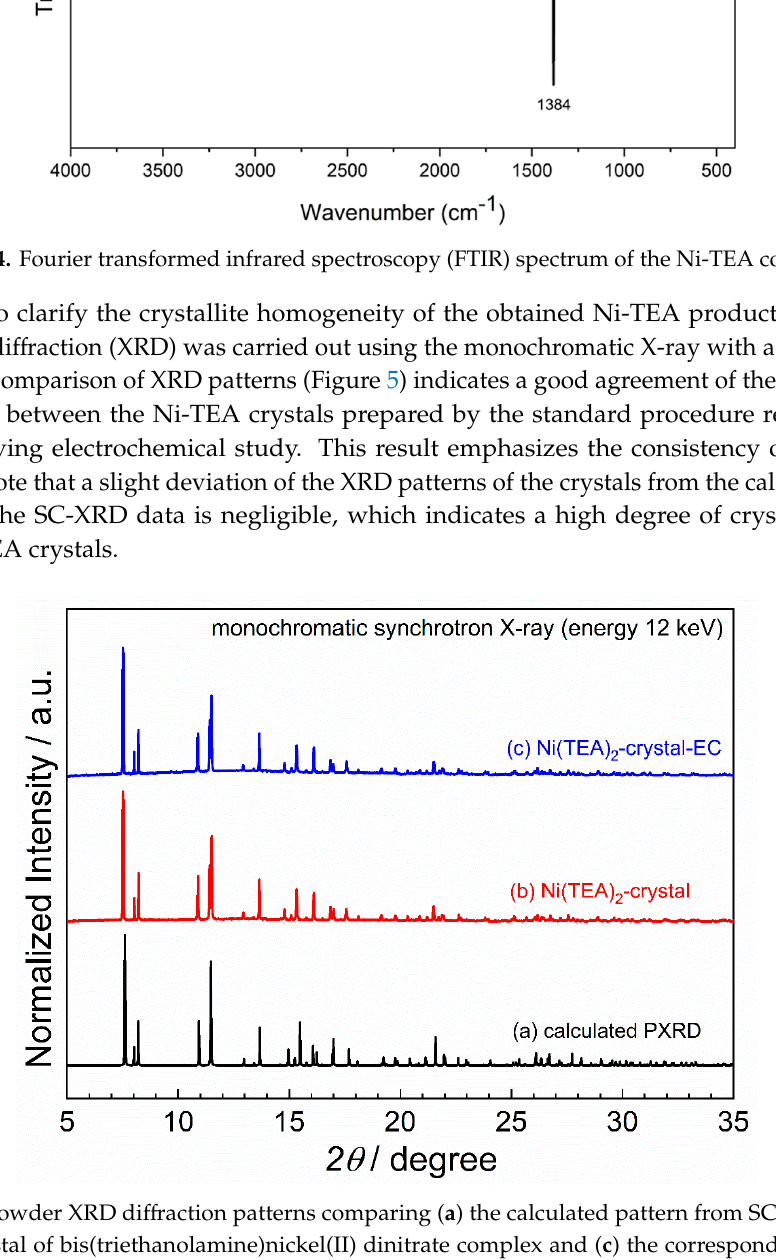
Figure 5. Powder XRD diffraction patterns comparing ( a ) the calculated pattern from SC-XRD data, ( b ) the crystal of bis(triethanolamine)nickel(II) dinitrate complex and ( c ) the corresponding crystal obtained from electrochemical studies. Table 3. Elemental compositions of the obtained Ni-TEA crystals examined by wavelength dispersive X-ray fluorescence (WD-XRF) compared to the calculated data derived from the Ni-TEA single crystal (excluding H atoms).